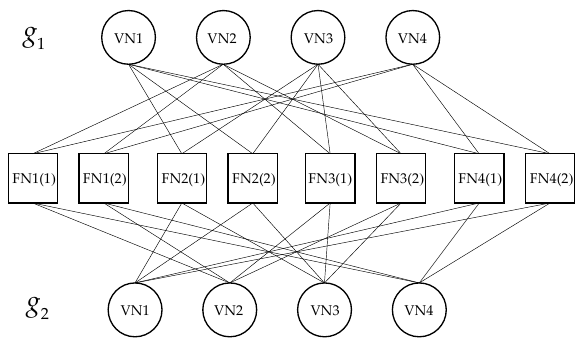
Figure 8. Joint factor graph.